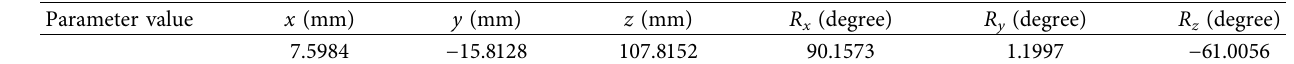
Table 4: The probe coordinates in the last link of robot.